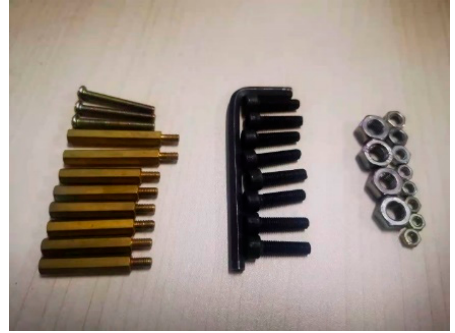
Figure 11. Physical figure of metal target.